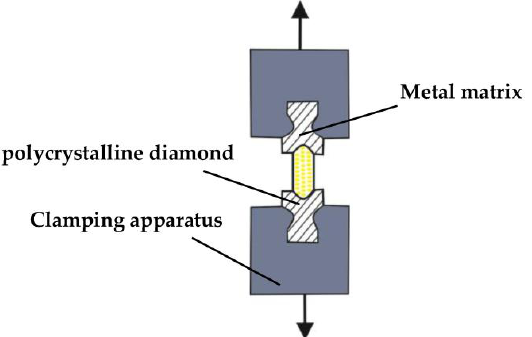
Figure 15. Scheme of tensile test method.